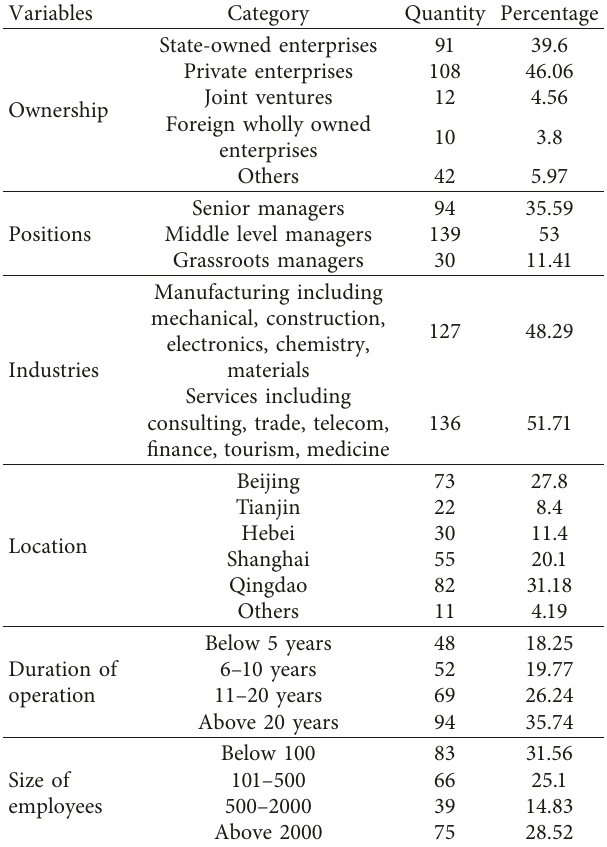
Table 1: Summary of the basic situation of research enterprises.